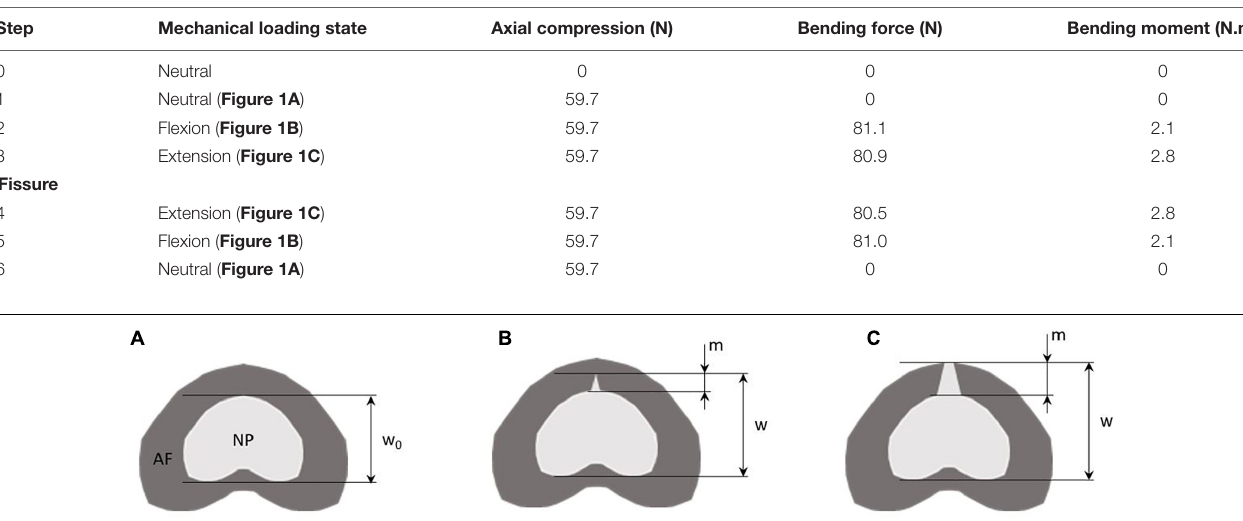
TABLE 1 | Mechanical states and the corresponding estimated boundary conditions of the specimen.